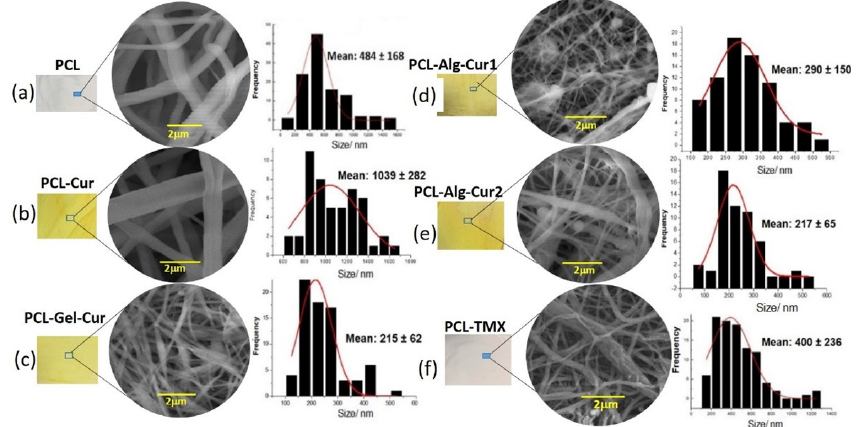
Figure 1. Morphology and diameter distribution of the nanofibers. SEM micrographs and diameter distribution histograms of uniaxial and coaxial PCL nanofibers: ( a ) PCL ( b ) PCL–Cur ( c ) PCL–Gel–Cur ( d ) PCL–Alg–Cur1 ( e ) PCL–Alg–Cur2 and ( f ) PCL–TMX.